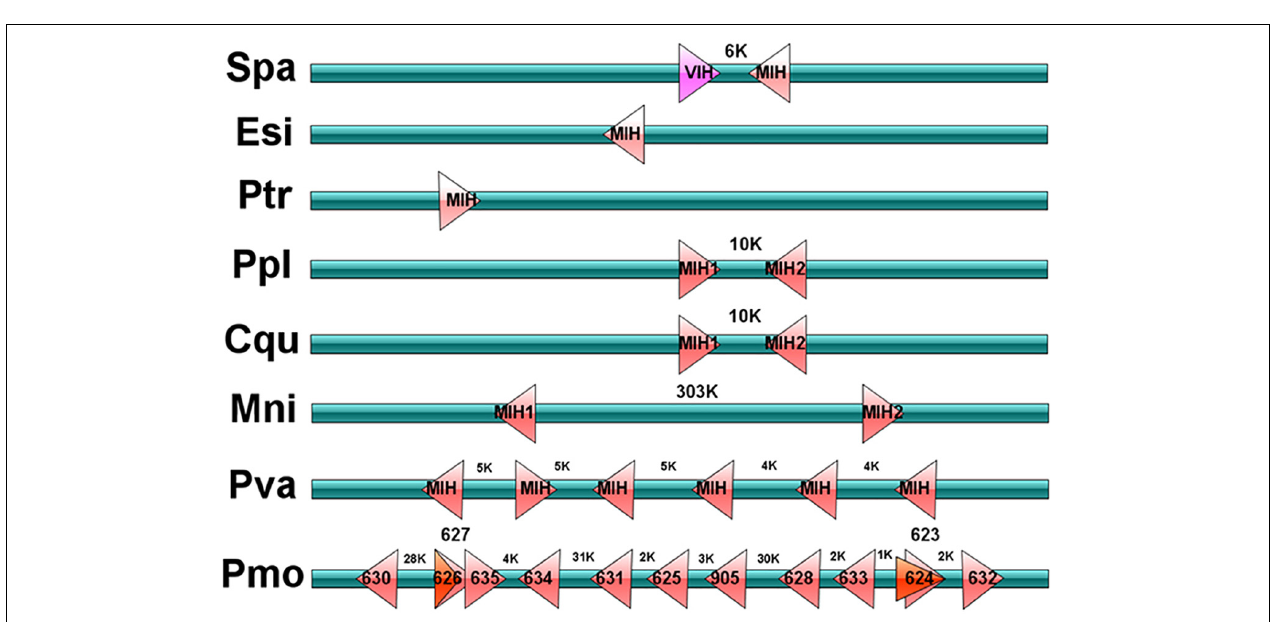
FIGURE 3 | Schematic representation of type II CHH genes in decapods. Schematic diagram showing type II CHH (MIH and VIH) genes location in the scaffold of genomic assembles from S. paramamosain, P. trituberculatus , E. sinensis , P. platypus , C. quadricarinatus , M. nipponense , P. vannamei , and P. monodon . “K” represents Kilobase pair. In schematic of P. monodon , numbers in each block represents the designation of P. monodon type II CHHs, and these information are obtained from Supplementary Material